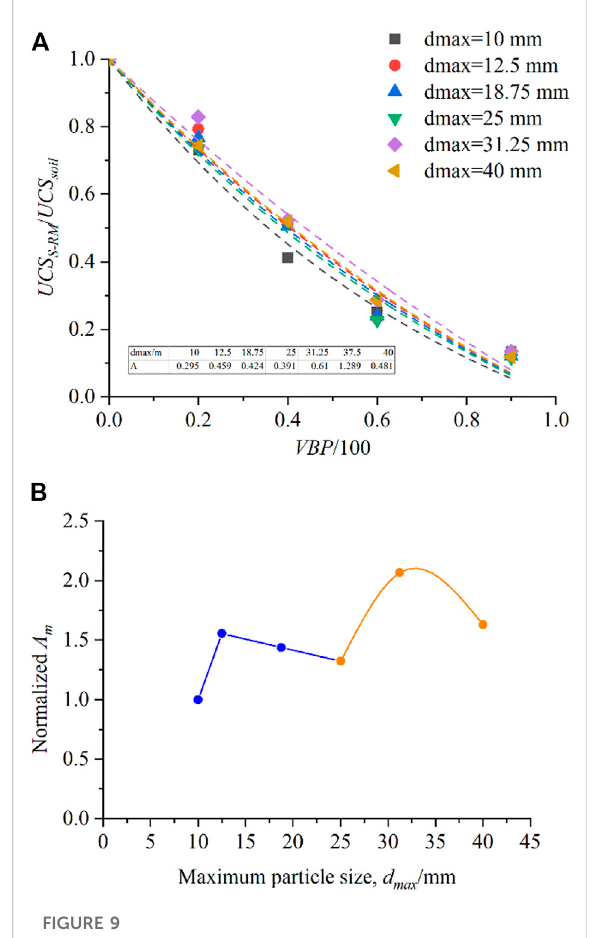
FIGURE 9 (A) Normalized UCS ; (B) characteristic parameter A of S-RM with different d max